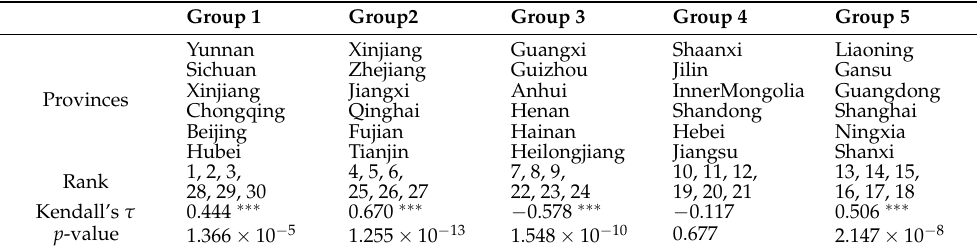
Table 14. The grouping results according to the E-E cost, and Kendall’s τ estimation between RCI and regional carbon efficiency for the six provinces in each group. Group numbers 1–5 represent intra- group differences from the largest to the smallest. ∗∗∗ stands for statistical significance at 1%